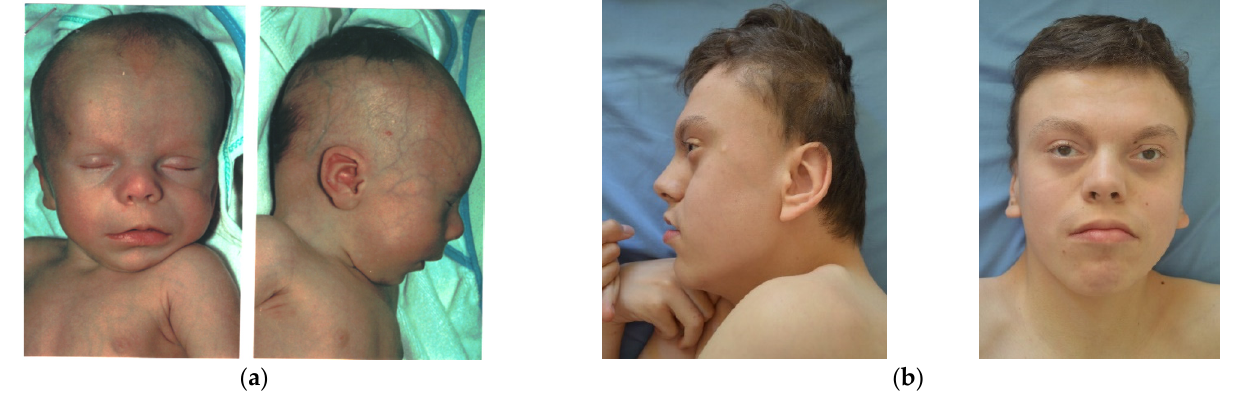
Figure 4. Clinical features of patient 2: ( a ) 1.5 mo old; ( b ) 16 y old. Brain CT: Symmetric dilatation of basal cisterns and subarachnoidian space, moderate dilatation of the ventricular system. Babygram (1.5 mo old): Hypoplastic humerus, delayed ossification of the cranial vault.